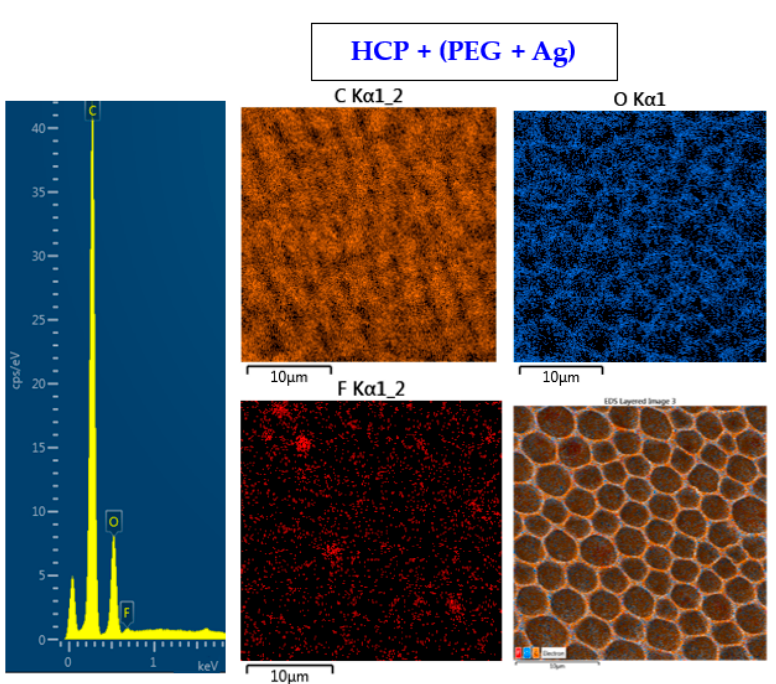
Figure 3. EDS spectrum and elemental maps with layered EDS images for the honeycomb-like (HCP) structure on the plasma-treated fluorinated ethylene propylene (FEP).